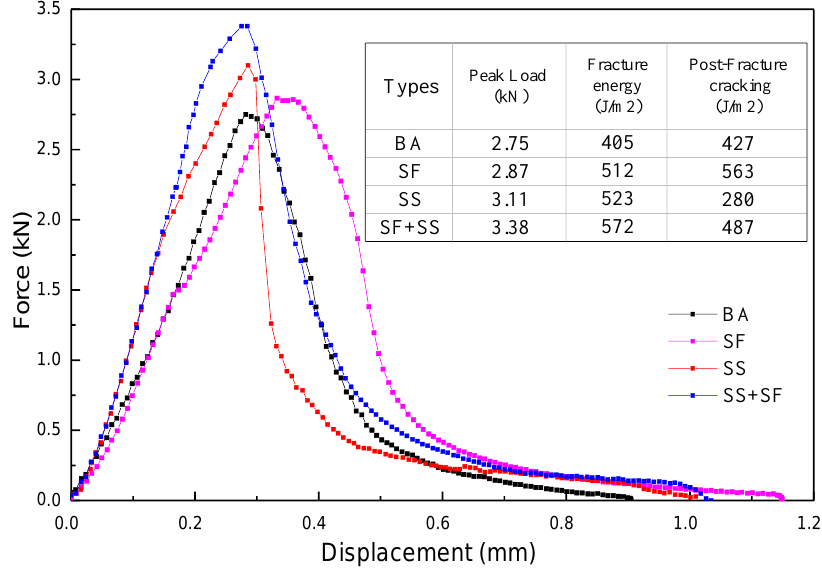
Figure 6. Fracture energy and post-cracking energy of different asphalt mixtures.